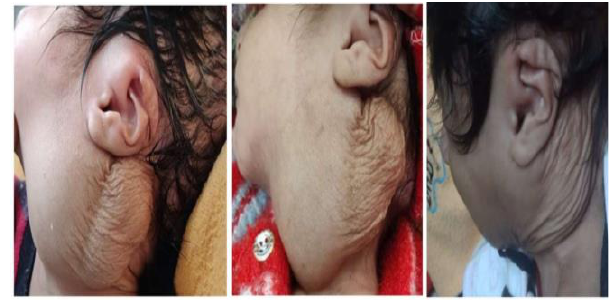
Figure 2: Sequence of pictures showing reduction in size of the lesion